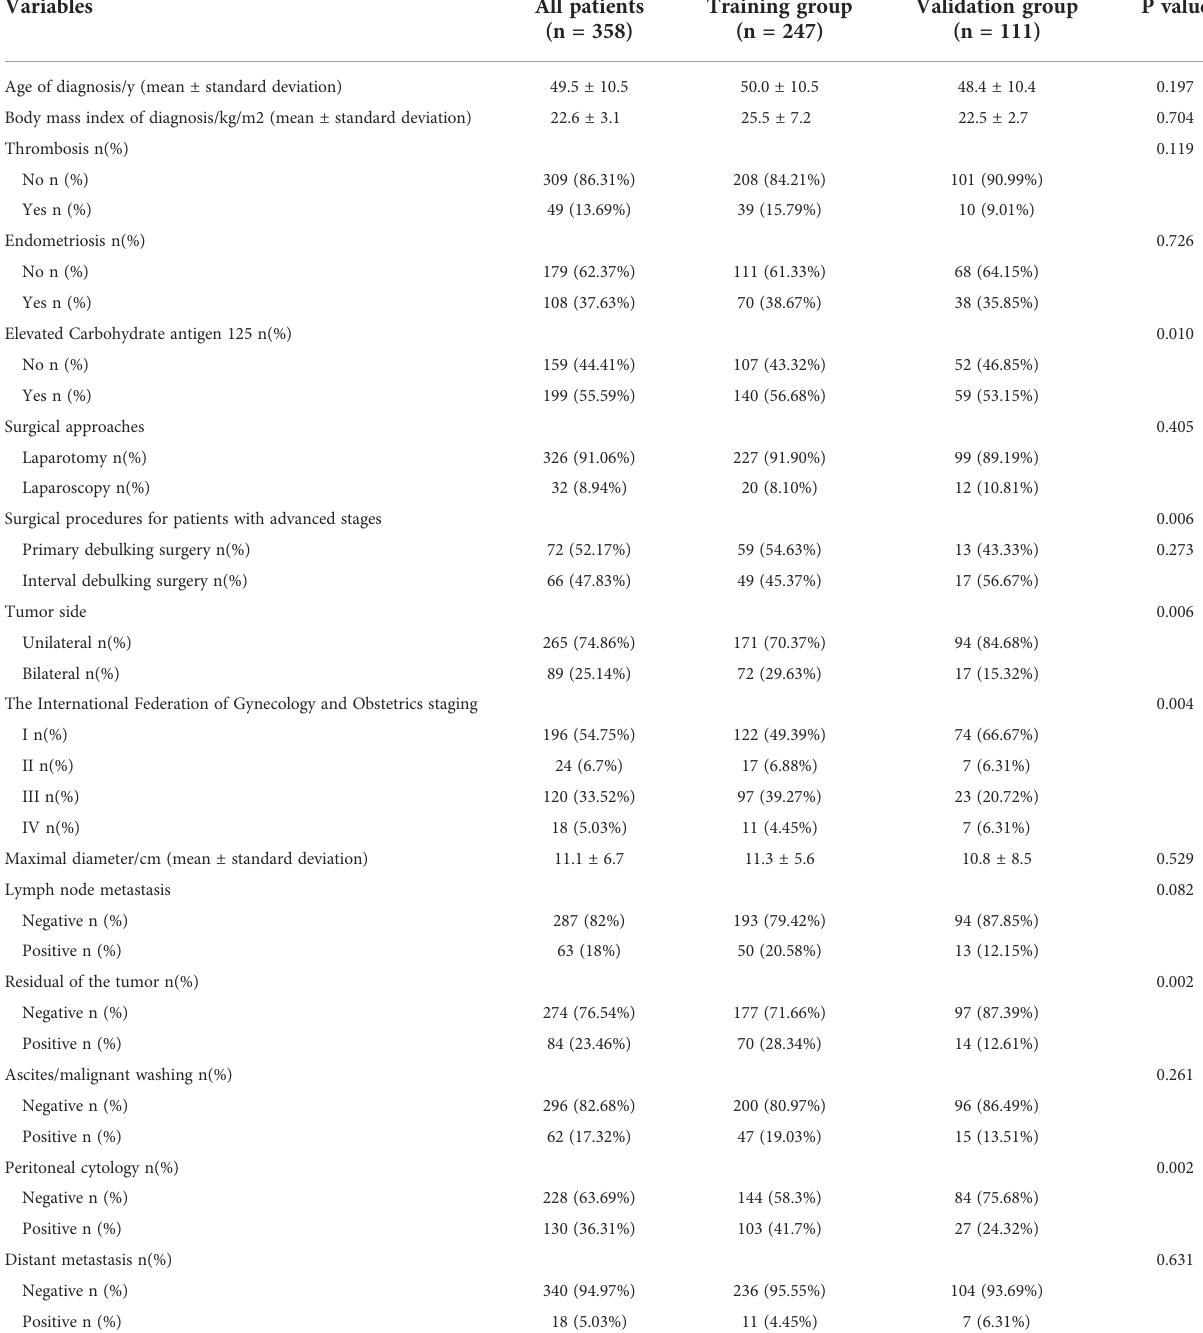
TABLE 1 Patients ’